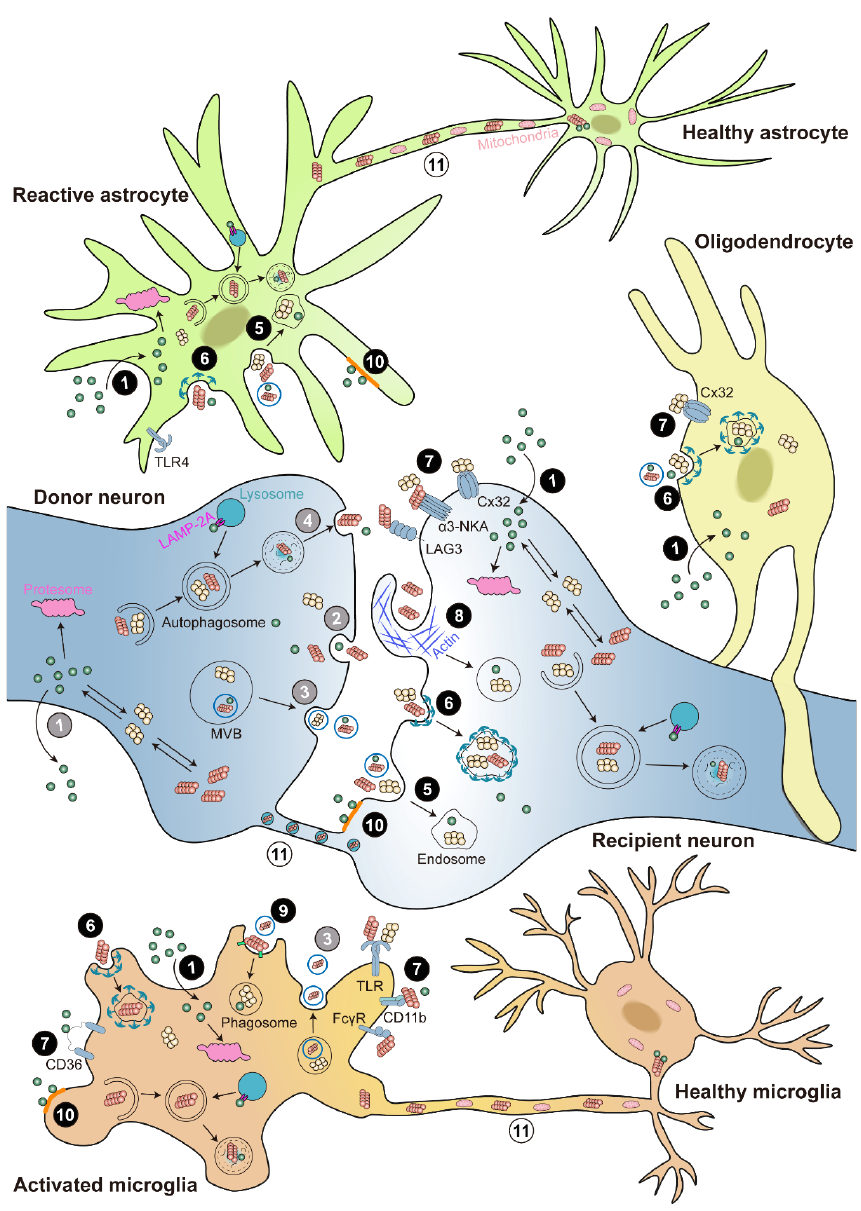
Figure 2. Cell-to-cell transmission of α -syn. Illustration of α -syn cell-to-cell transmission. α -syn could transfer between neurons and glia. α -syn is released via 1 (cid:13) passive diffusion (only monomer), 2 (cid:13) exocytosis, 3 (cid:13) exosomes, or 4 (cid:13) exophagy (grey color numbers). α -syn is taken up via 1 (cid:13) passive diffusion (only monomer), 5 (cid:13) endocytosis, 6 (cid:13) clathrin-mediated endocytosis (CME), 7 (cid:13) receptor- mediated internalization, 8 (cid:13) micropinocytosis, 9 (cid:13) phagocytosis, or 10 (cid:13) lipid raft (black color numbers). The receptors involved in α -syn internalization include lymphocyte-activation gene 3 (LAG3), α 3-subunit of Na+/K+-ATPase ( α 3-NKA), and the gap junction protein connexin-32 (Cx32) in neuron; Toll-like receptors 2 and 4 (TLR2 and TLR4), the scavenger receptor CD36, integrin CD11b, and the Fc γ receptors (Fc γ R) in microglia; and Cx32 in oligodendrocyte. In addition, α -syn can directly cell-to-cell transfer by 11 (cid:13) tunneling nanotubes (TNTs) (white color numbers). Internalized α -syn are degraded via the ubiquitin-proteasome system (UPS), autophagy, and chaperone-mediated autophagy (CMA)